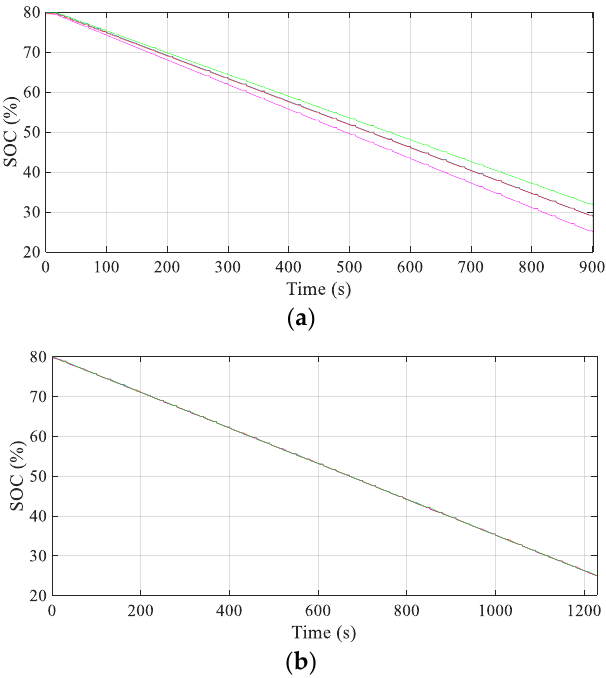
Figure 14. SOCs during discharging: ( a ) passive balancing; ( b ) proposed SBP with active balancing. Each line corresponds to the SOC of one of the cells in the considered battery pack.